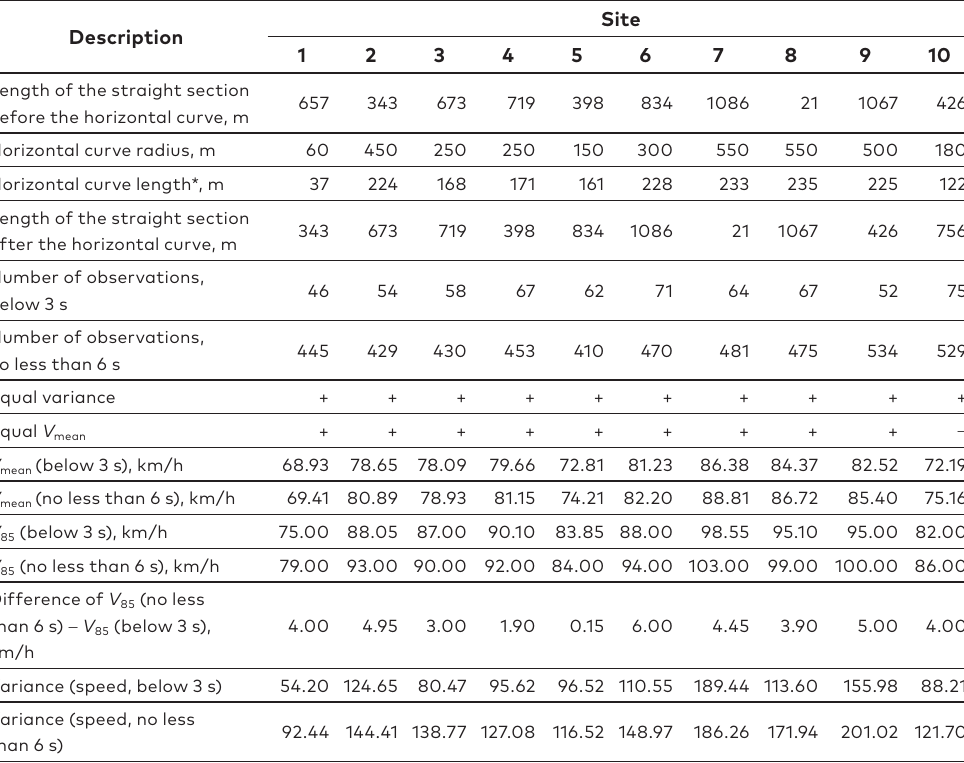
Table 4. Descriptive results of unisolated-isolated